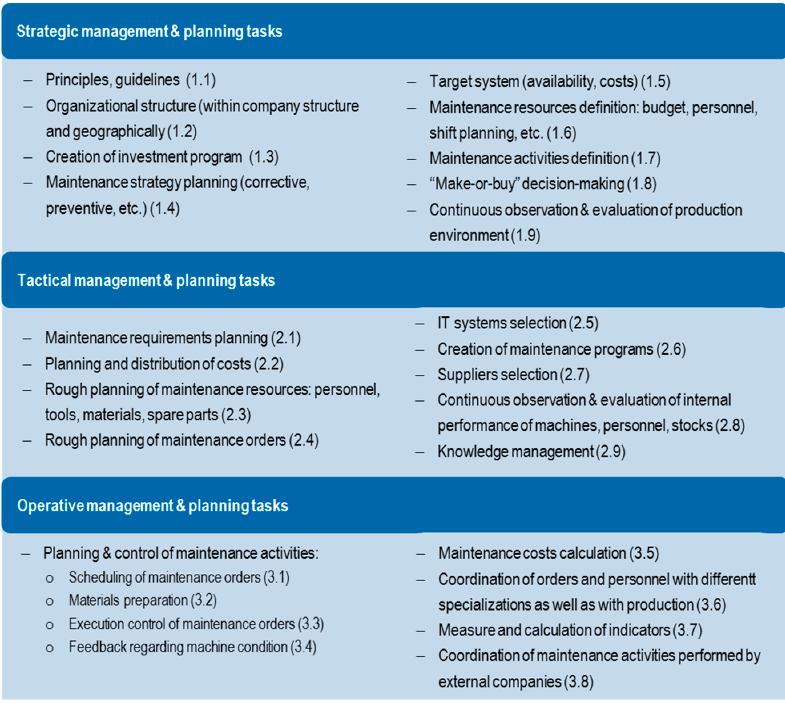
Figure 5. Maintenance management and planning tasks acc. to time horizons (own elaboration).